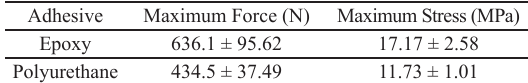
Table 2. Adhesive